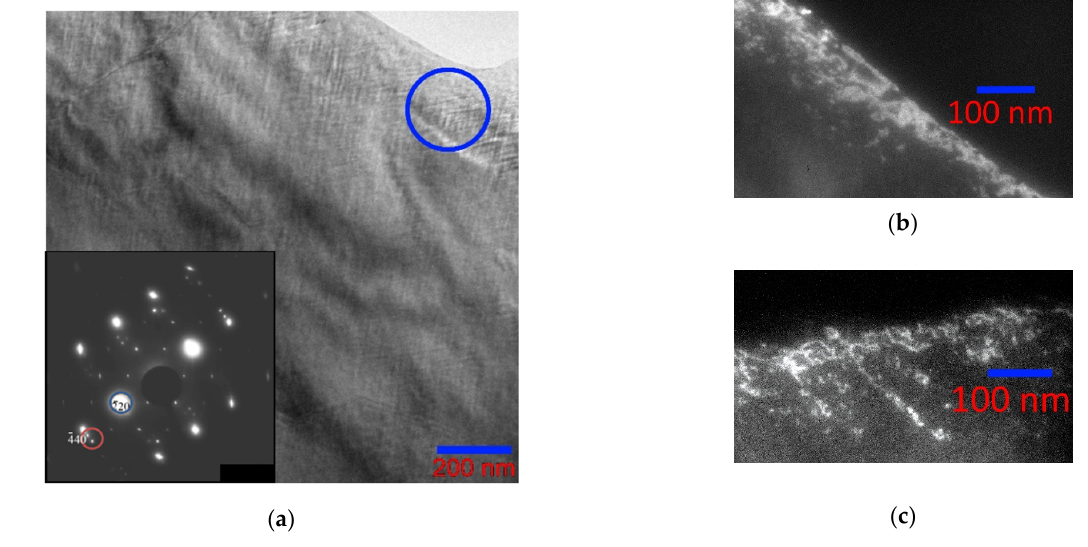
Figure 9. Bright-field image of the structure of the Ni 46 Mn 41 In 13 alloy ( a ) (inset: SEAD electron diffraction pattern from the region in the upper right corner (tweed contrast) with the zone axis [110] L21 and dark-field images in reflections ( 2 20) L21 ( b ) and ( 4 40) L21 ( c ).